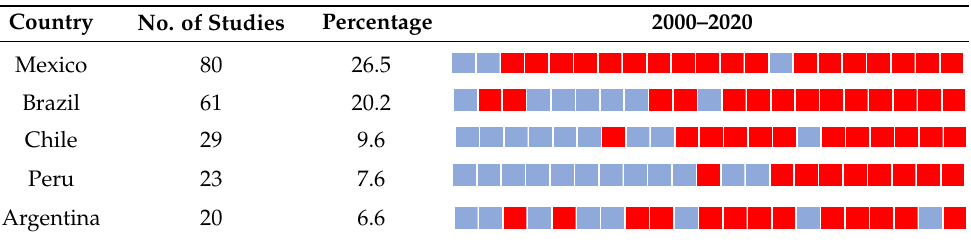
Table 1. Record and growth of flood-related publications in WoS journals of the top five leading LAC countries.